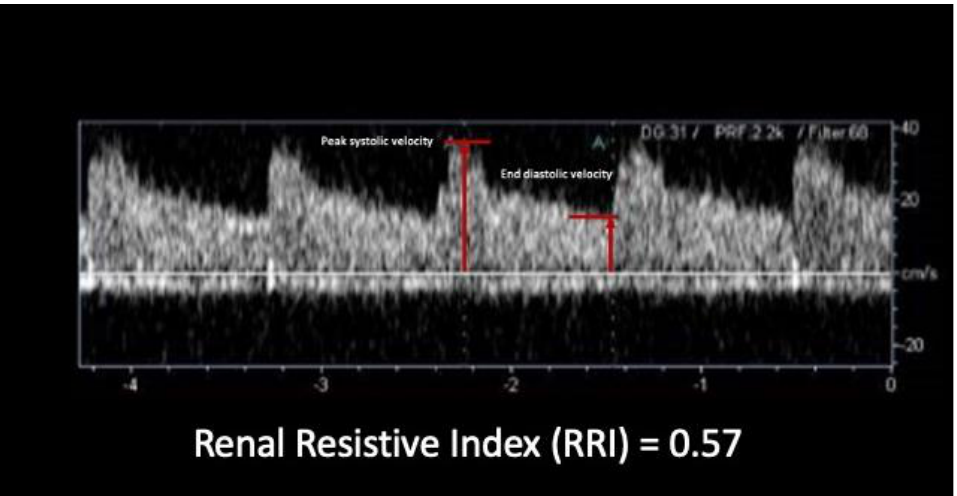
Figure 2. RRI calculation in the Doppler analysis. The figure shows a typical low resistance Doppler spectrum in a renal interlobar artery. The markers highlighted are related to the maximum systolic peak and to the end-diastolic velocity which are used for the calculation of the RRI. Both markers are measured in the same cardiac cycle.